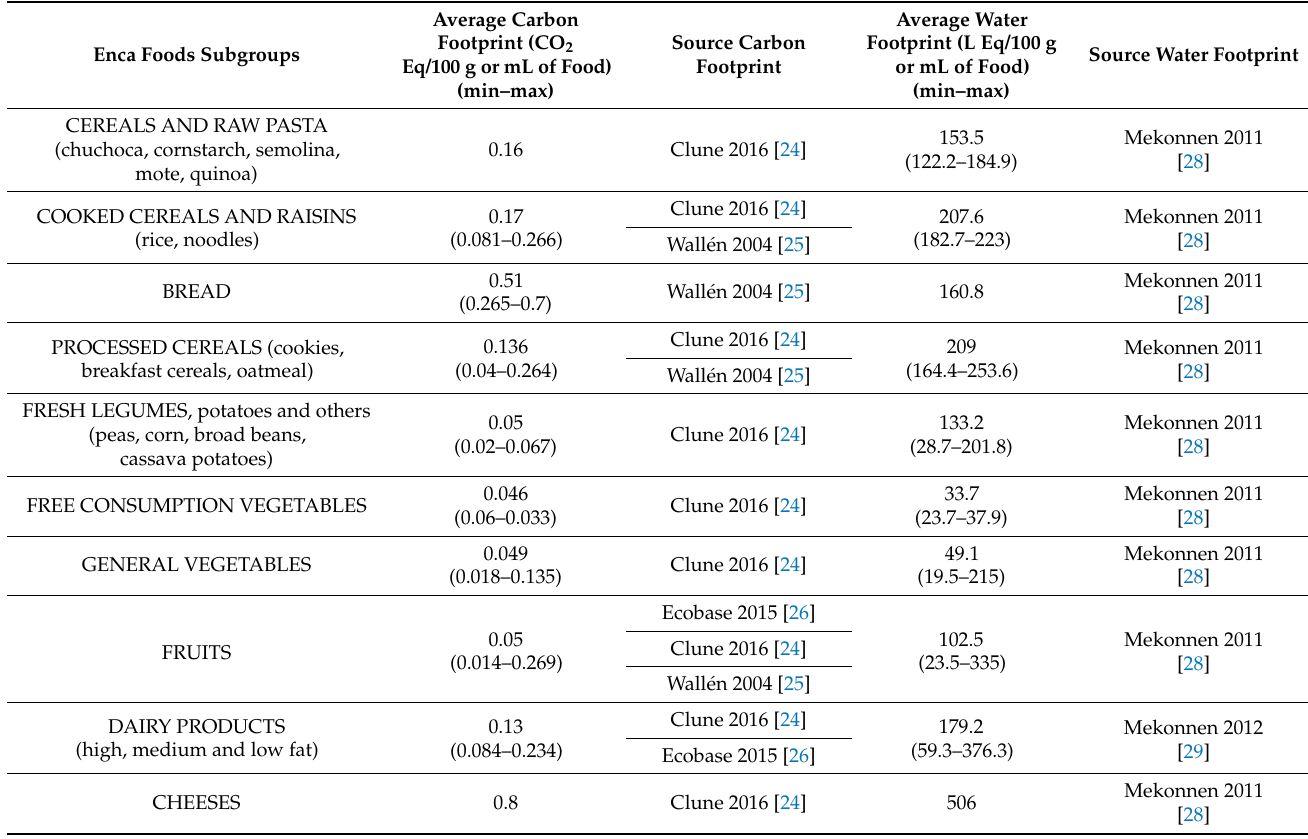
Table A3. References used for water footprint and carbon footprint and averages of the Kg CO 2 and L eq values of each subgroup in relation to 100 g or 100 mL of food, with ranges (minimum–maximum) of the